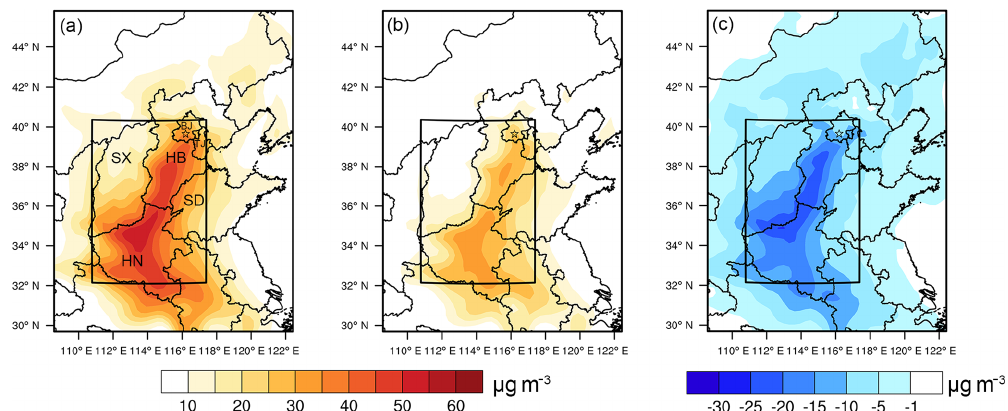
Figure 2. Spatial distribution of particulate-NO − concentrations in northern China predicted by WRF-Chem from 6 to 10 December 2015, 3 for (a) the base case, (b) the emission reduction case, and (c) the difference between the base case and the emission reduction case. The scope of this study focuses on the black box, including Beijing (BJ), Tianjin (TJ), Hebei (HB), Shanxi (SX), Shandong (SD) and Henan